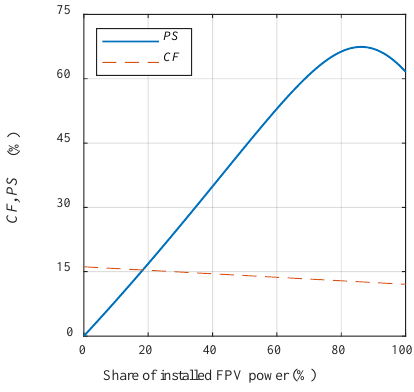
Figure 11. Capacity factor, CF , and Power Smoothing index, PS , for combined offshore wind and FPV farms as a function of share of installed FPV power capacity.